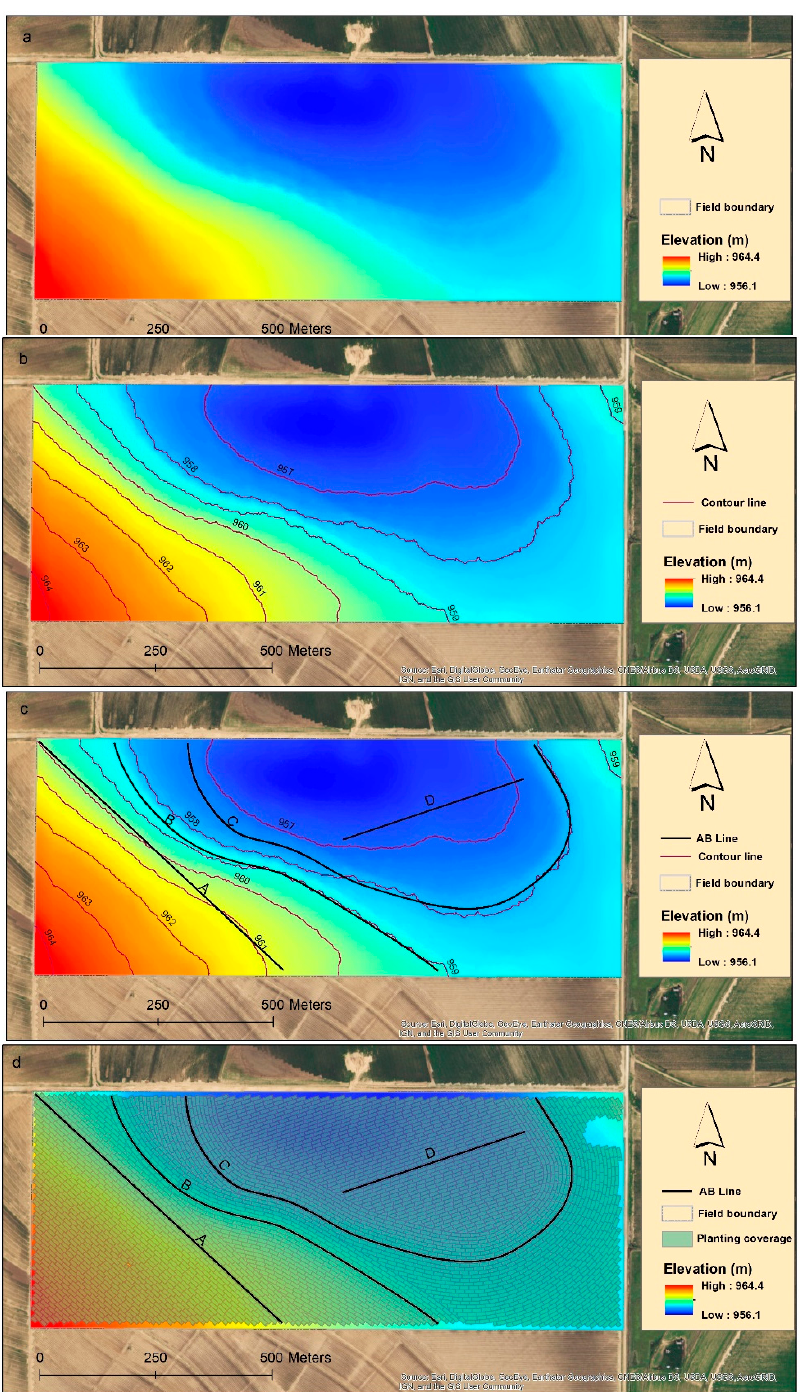
Figure 9. Guidance line creation from elevation data collected with an RTK guidance system in a slope field in the Southern High Plains of Texas. ( a ) Digital elevation model (DEM) from elevation data collected using an RTK guidance system; ( b ) contour lines generated from the DEM; ( c ) AB lines derived from the contour lines; ( d ) map showing planting coverage generated by a guidance system that guided to the designed AB lines.